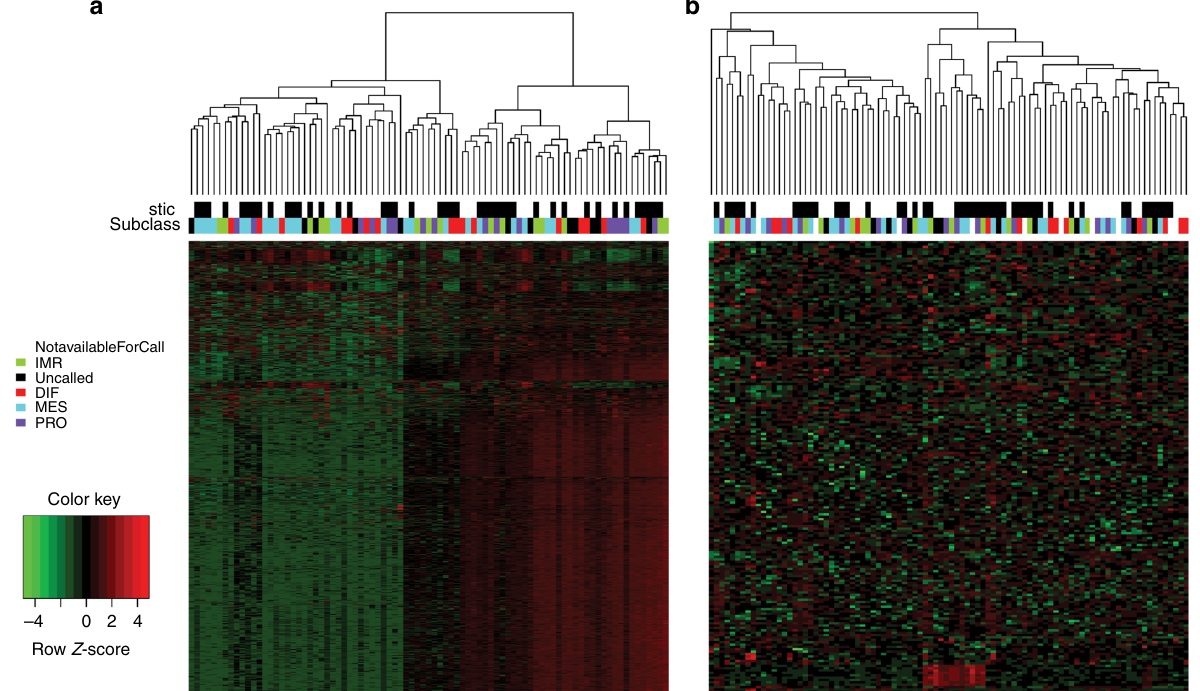
Fig. 3 Unsupervised clustering of the most variable genes. Unsupervised clustering analysis of the most variable mRNA ( a ) and microRNA ( b ) transcripts from 85 analyzed tumors with STIC lesion and TCGA subclass indicated in header rows. Samples are in columns and genes in rows